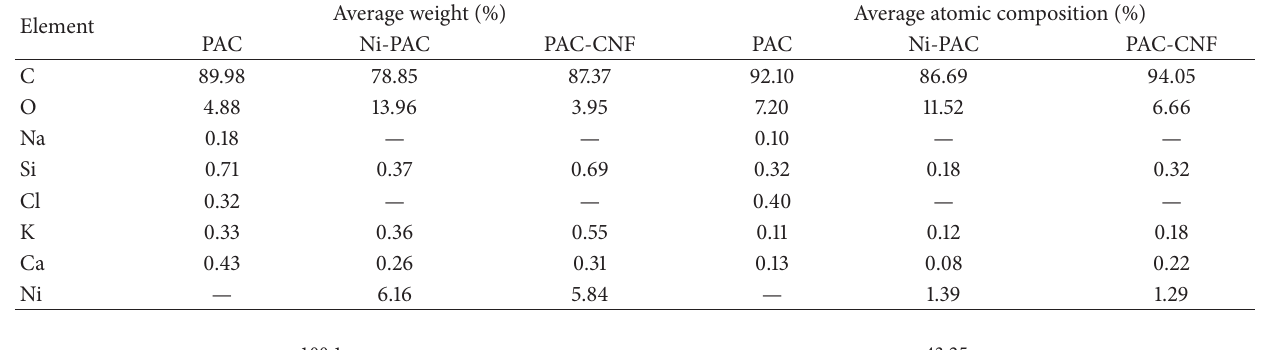
Table 4: Compositions of elements in PAC, Ni impregnated PAC, and PAC-CNF.